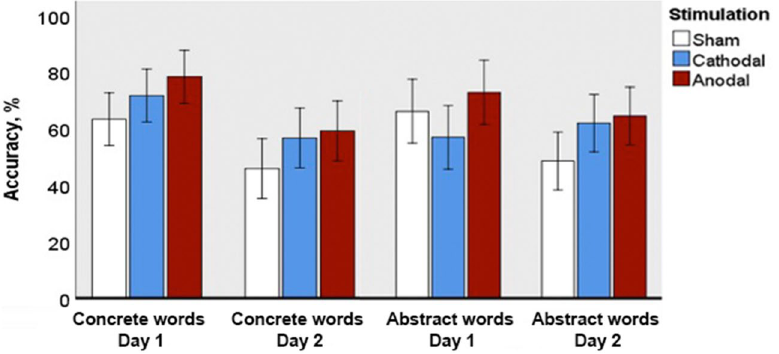
Figure 5. Accuracy in the semantic judgement task for novel concrete and abstract words immediately after learning (Day 1) and following an overnight sleep (Day 2). Error bars denote 95% confidence